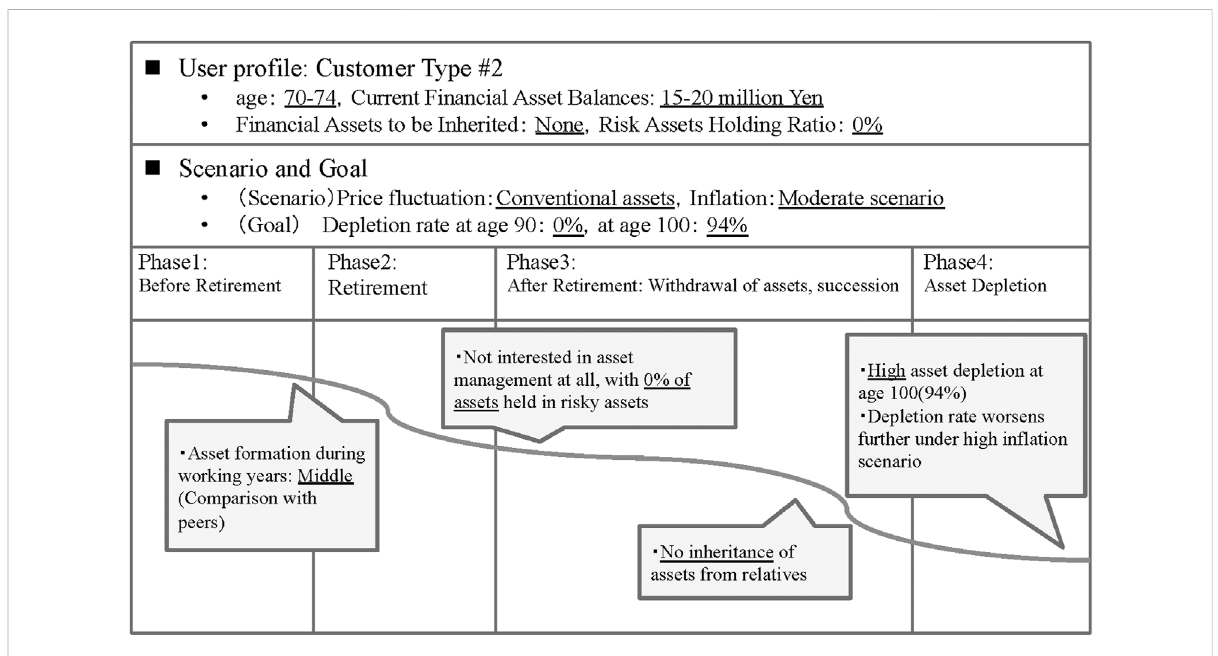
FIGURE 7 Simulation results described with Customer journey map (Customer type: #2).